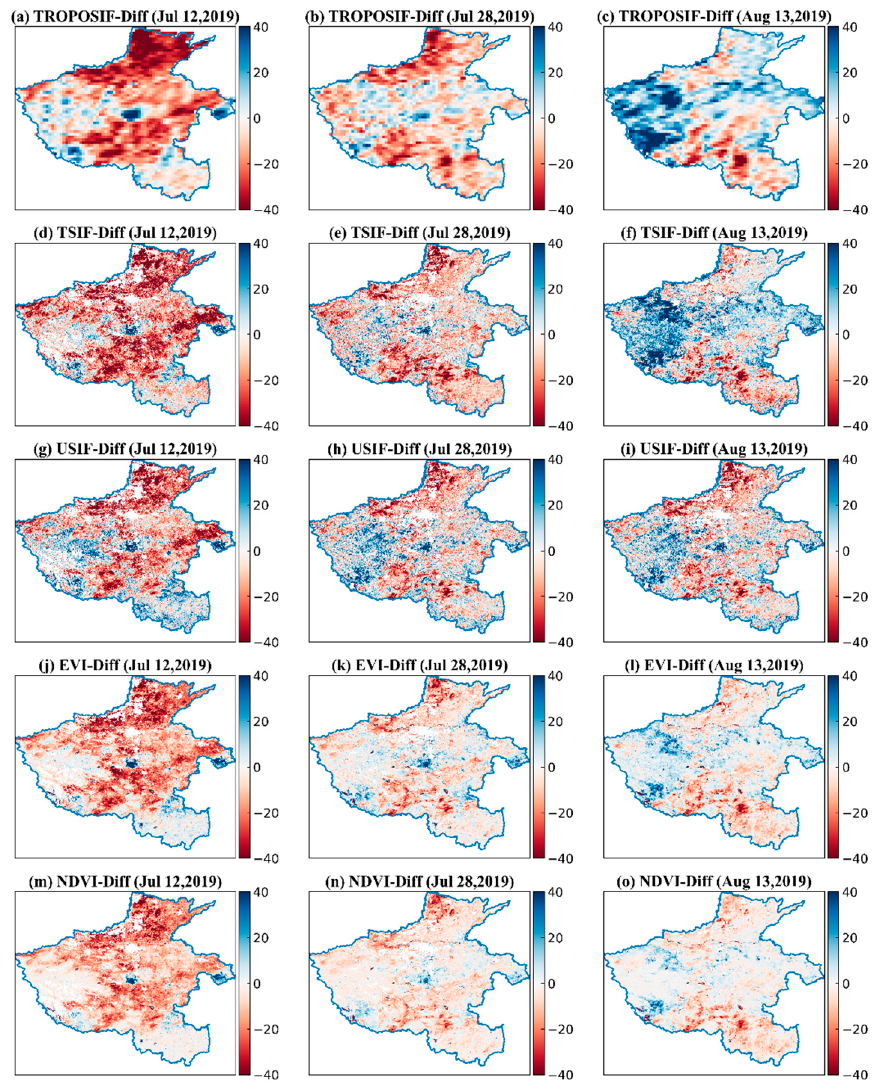
Figure 17. Spatial and temporal patterns of drought characterized by TROPOSIF-Diff ( a – c ), TSIF- Diff ( d – f ), USIF-Diff ( g – i ),EVI-Diff ( j – l ) , and NDVI-Diff ( m – o ) for July and August of 2019. ( d – f ), USIF-Diff ( g – i ),EVI-Diff ( j – l ), and NDVI-Diff ( m – o ) for July and August of